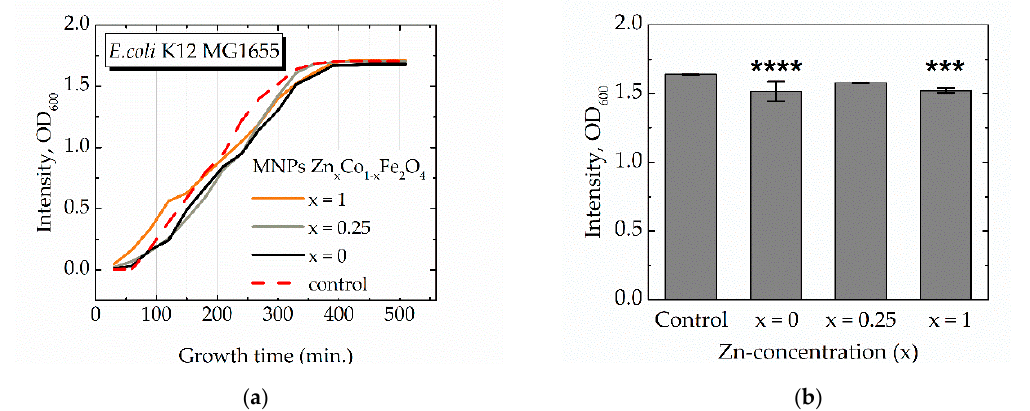
Figure 4. ( a ) Optical density (OD 600 ) of E.coli K-12 MG1655 in LB medium as a function of cultivation time in presence of MNPs; ( b ) saturated value of OD 600 after 330 min of cultivation (more data are in Figure S3).